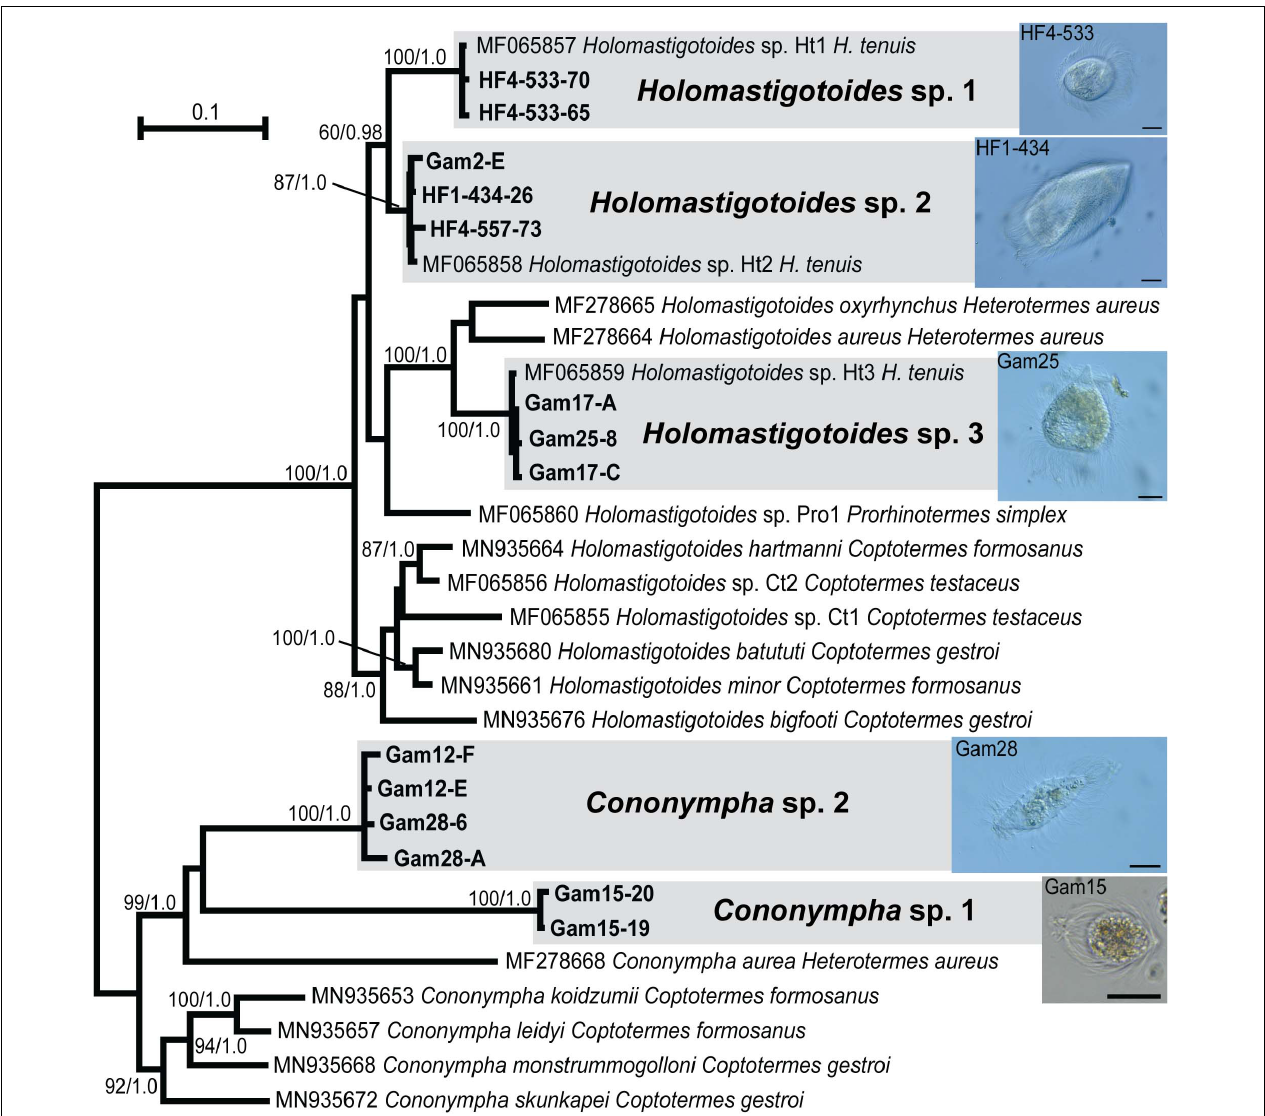
FIGURE 4 | Unrooted maximum likelihood phylogeny of 18S ribosomal RNA gene sequences from Spirotrichonymphida genera Cononympha and Holo- mastigotoides , each serving as outgroup for the other. Protist species-level phylotypes from H. tenuis are indicated by gray boxes and new sequences obtained in this study are indicated by bold text. Support at nodes is given out of 100 bootstrap replicates computed by RAxML/Bayesian posterior probabilities if greater than 60/0.95. New sequences from H. tenuis symbionts are indicated by bold text. Select cells from which new sequences were derived are shown in micrographs inset at right; sequence names (tip labels) include the cell code. All scale bars: 20 µ